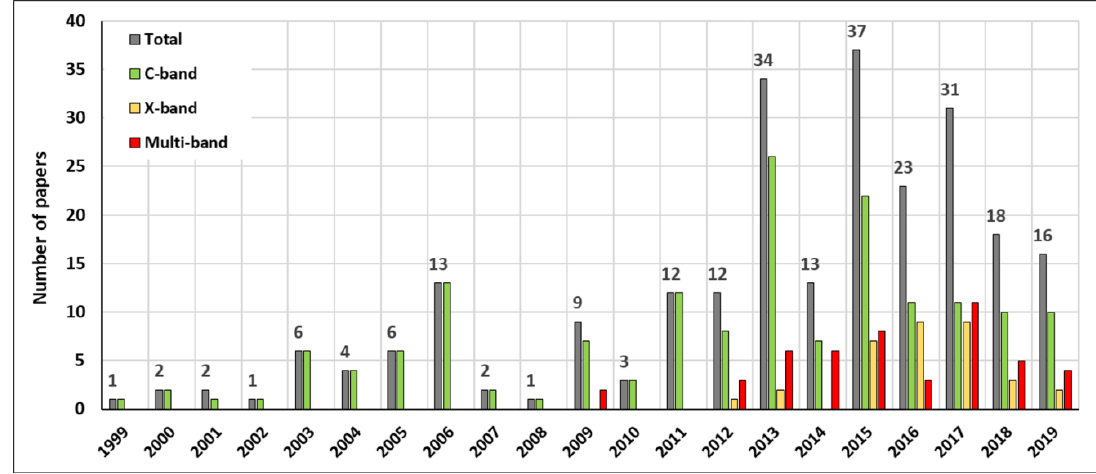
Figure 1. Scientific papers published per year from 1999 to 2019 subdivided for satellite acquisition band. Multi-band refers to different combinations between C-, X-, and L-band SAR images.